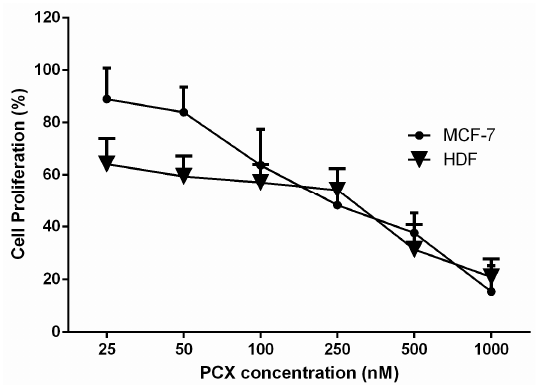
Figure 7. Antiproliferative effect of PCX on MCF-7 human breast cancer cells and HDF human dermal fibroblast cells ( n = 6, ±SD).